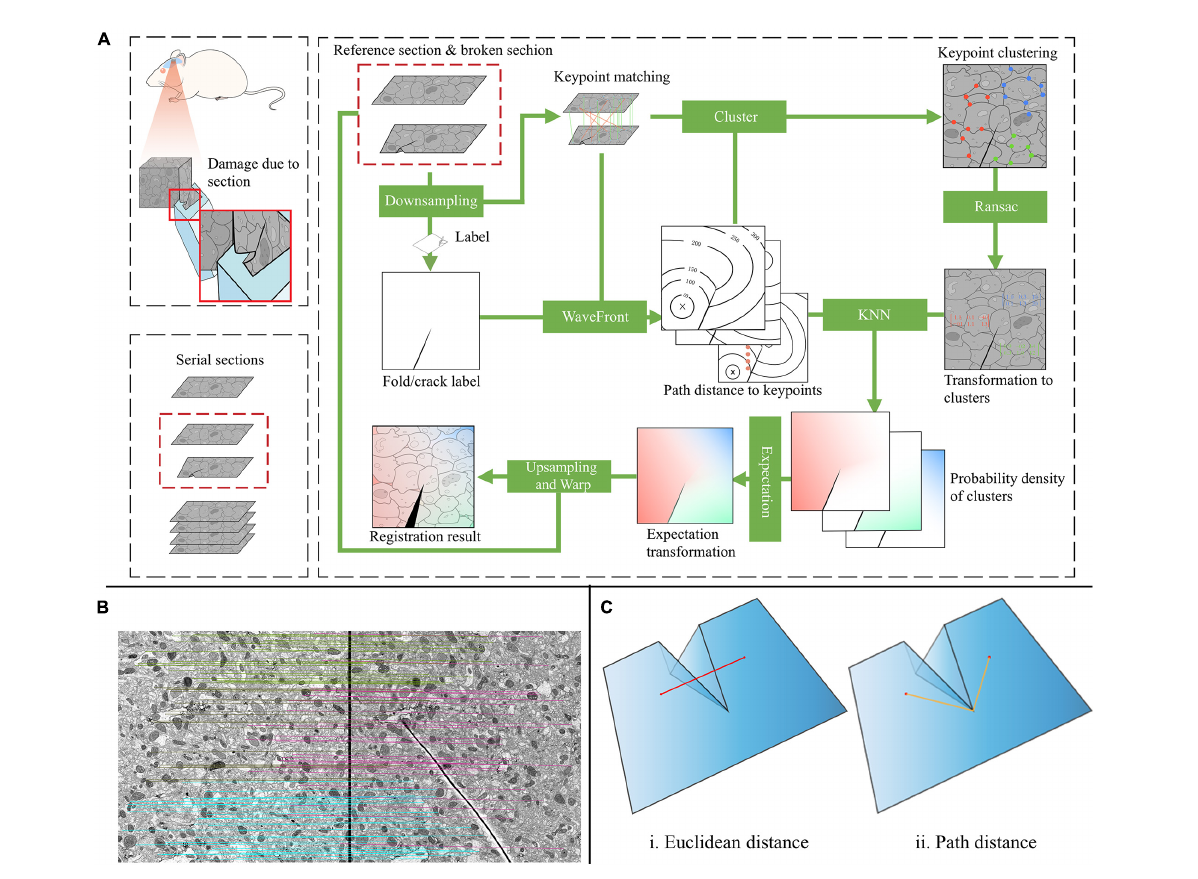
FIGURE2 (A) Appearance damaged section and the overall excepted affine pipeline. (B) The match between the reference section and the folded section. Different colors represent different clusters. (C) Correlation measures between points on different sides of the